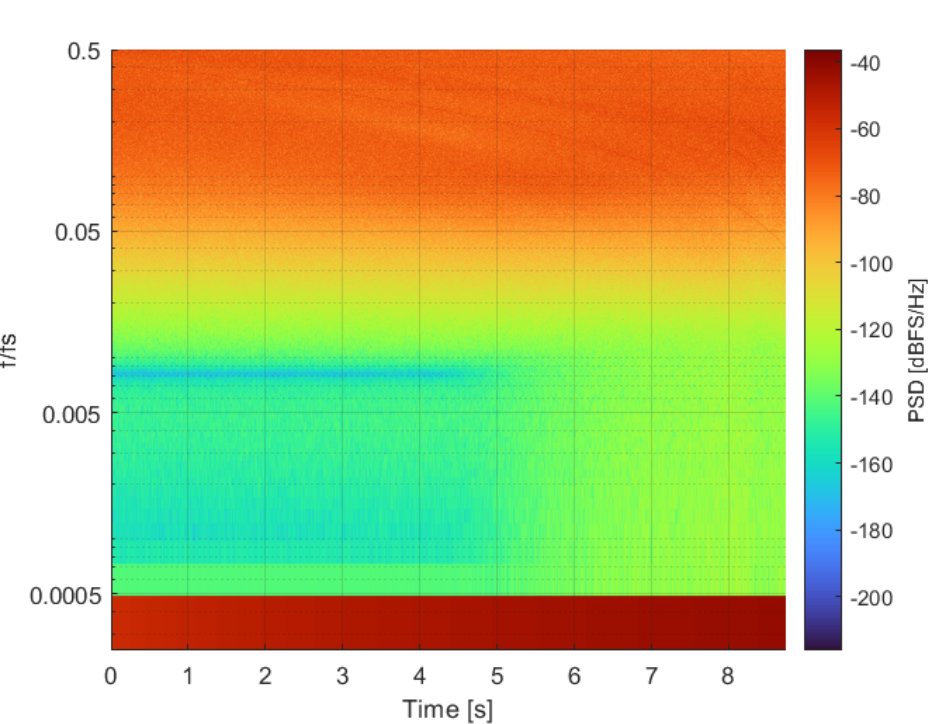
Figure 4. Spectrogram of the Σ∆ M output; the signal is divided into 8192 segments of 1.06 ms to compute the spectrogram. Input signal is a ramp that starts at 0.01 V and ends at 0.06 V. Modulator parameters are: third-order, 4-bits, BW = 20 kHz, OSR = 48, OBG =